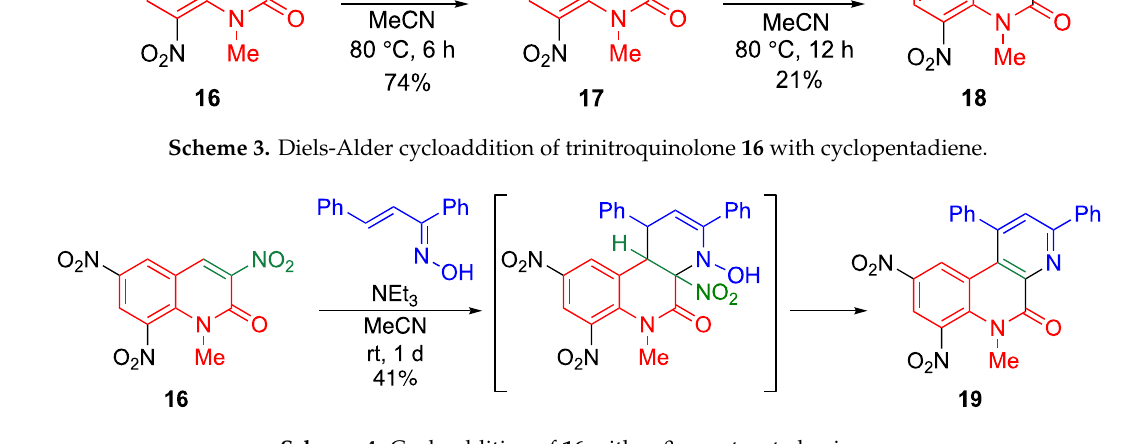
Figure 4. ORTEP (30% probability ellipsoids) view of trinitroquinolone 16 . A nitroalkene shows dual behavior in cycloaddition reactions (Figure 5). In reaction with a diene, the nitroalkene serves as a dienophile to form a cyclohexene ring. On the other hand, it serves as a heterodiene in reaction with an electron-rich alkene to construct an oxazine ring. The nitroalkene moiety of trinitroquinolone 16 also serves as a heterodiene in the reaction with ethoxyethene to construct a fused oxazine ring 20 (Scheme 5) [38], which yields an acetal 21 via ring-opening reaction upon treatment with alcohol under reflux conditions. Figure 5. Dual behaviors of a nitroalkene in the cycloaddition reaction.